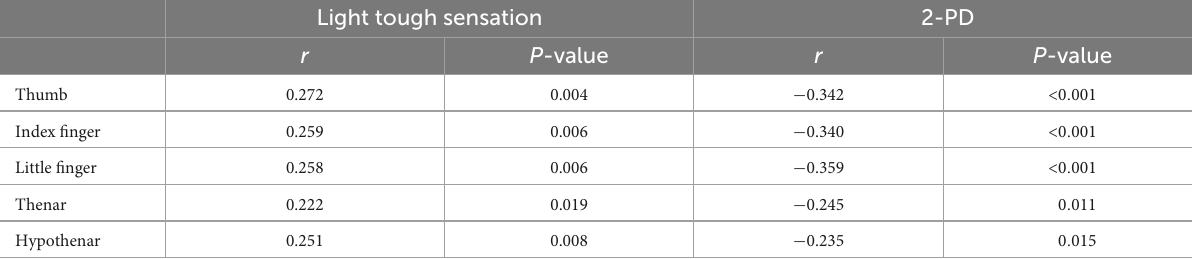
TABLE 6 The relationship between hemiplegic hand function and